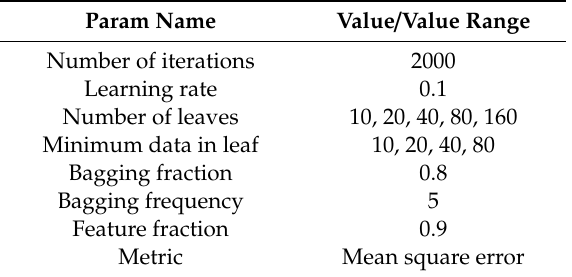
Table 7. LightGBM parameters configuration and parameter tuning ranges.